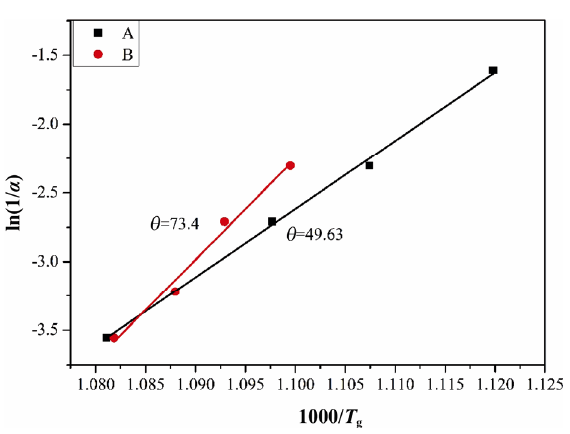
Fig. 5 ln(1/ α ) versus 1000/ T g for A and B glass. Table 3 Activation energies for the glass transition ( E t ) and crystallization ( E c ) of A and B glass Sample